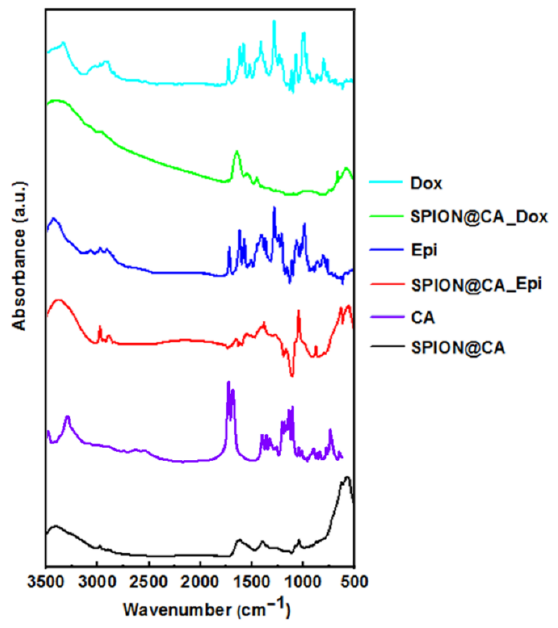
Figure 4. FT-IR spectra for Dox, Epi, SPION@CA, SPION@CA_Dox, and SPION@CA@Epi.